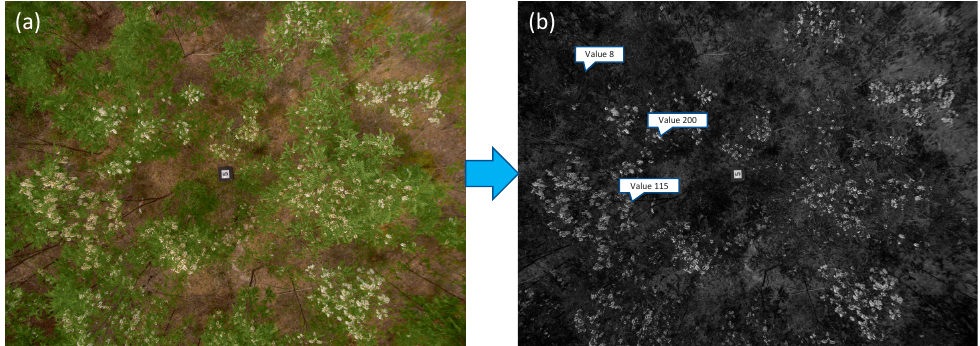
Figure 2. Red–green–blue (RGB) aerial picture ( a ) with the scale bar in the middle of the field. Blue-channel view of picture ( b ) with three example pixel